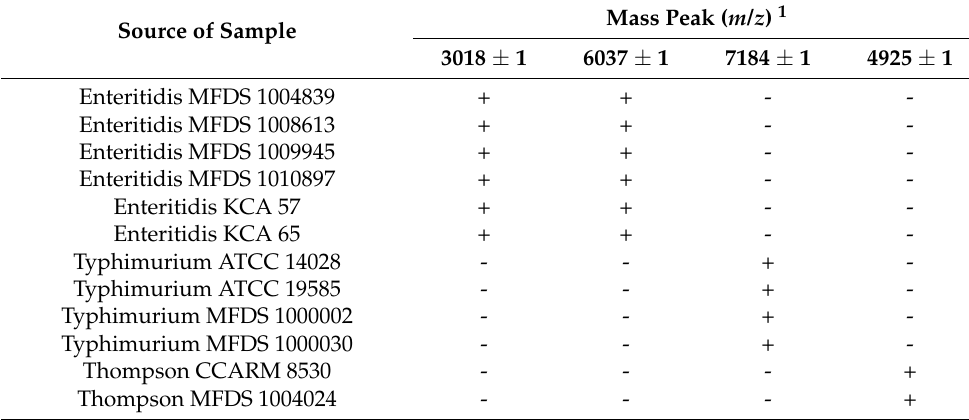
Table 3. Presence/absence of specific peaks for 12 reference